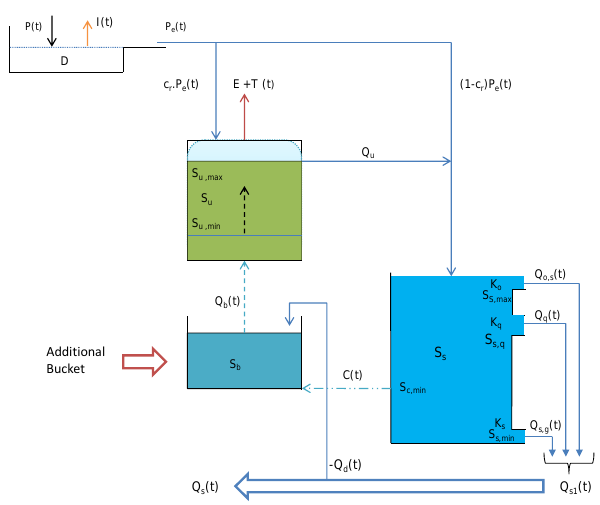
Figure 2. Modified STREAM conceptual model for upper Pangani River